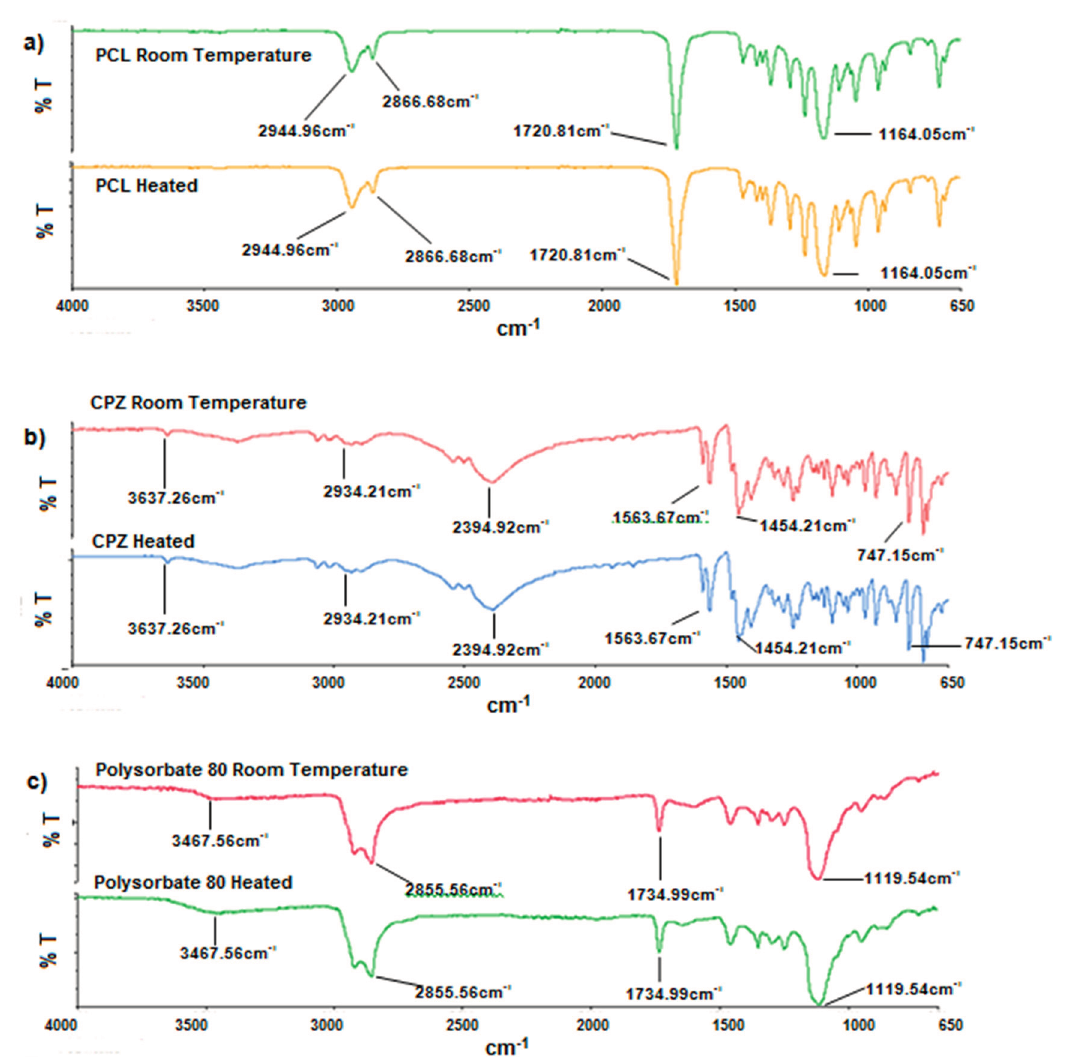
Figure 3. FTIR spectra of ( a ) PCL (room temperature and heated); ( b ) CPZ (room temperature and heated, and ( c ) Polysorbate 80 (room temperature and